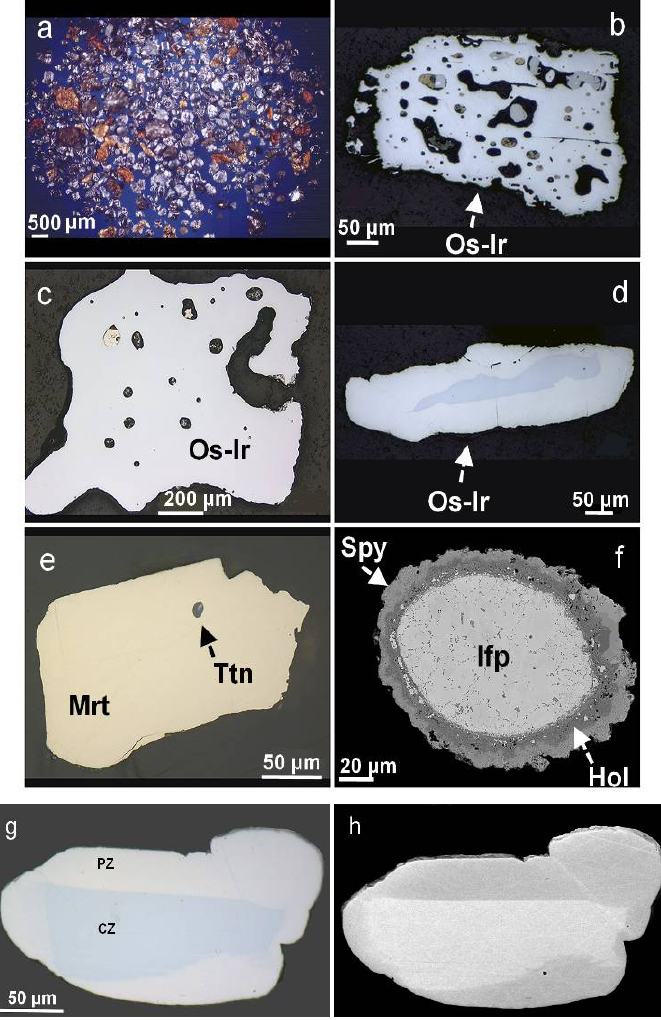
Figure 2. ( a ) Microscopic image showing grains of placer platinum-group mineral (PGM) concentrate, the size of which is generally ~0.1–0.5 mm, collected from the Sisim placer zone and analyzed in the present study. The bulk of these grains (up to ~80%) are Os–Ir–(Ru) alloy minerals (i.e., the minerals osmium and iridium). Grains of Pt–Fe alloy are subordinate (<20%); ( b , c ). Grains of Os–Ir alloy (Os–Ir), observed in a polished mount, contain various inclusions; ( d ) A grain of sharply zoned Os–Ir alloys, consisting of Os-rich core and Ir-rich rim; ( e ) Subhedral grain of mertieite-II (Mrt), hosting a tiny inclusion of titanite (Ttn); ( f ) Back-scattered electron (BSE) image displaying a rounded grain of isoferroplatinum (Ifp; Rh–Ir–Cu–bearing) [(Pt 2.57 Rh 0.28 Ir 0.17 Os 0.09 Ru 0.05 ) Σ 3.16 (Fe 0.66 Cu 0.17 Ni <0.01 ) Σ 0.84 ], which is mantled by a composite rim that consists of a S-deficient phase of hollingworthite (Hol, dark grey: the internal rim) [(Rh 0.94 Pt 0.18 Fe 0.03 Ir 0.01 ) Σ 1.84 As 1.15 S 0.69 ], and an outer rim composed of a metal-deficient sperrylite (Spy) [(Pt 0.71 Rh 0.17 Fe 0.04 Ni <0.01 ) Σ 0.92 (As 1.82 S 0.26 ) Σ 2.08 ]; ( g ) A reflected light microphotograph and ( h ) BSE image showing a sharply zoned grain of Os–Ir–(Ru) alloy from the Sisim placer zone; the core zone (CZ, blue in Figure 2g) has the composition Os 92.6 Ir 6.5 Ru 0.7 Fe 0.10 Ni 0.10 . The wavelength-dispersive spectroscopy (WDS) composition of the periphery zone (PZ) is Os 48.0 Ir 29.1 Ru 18.9 Pt 2.5 Rh 1.0 Fe 0.47 Ni 0.15 .